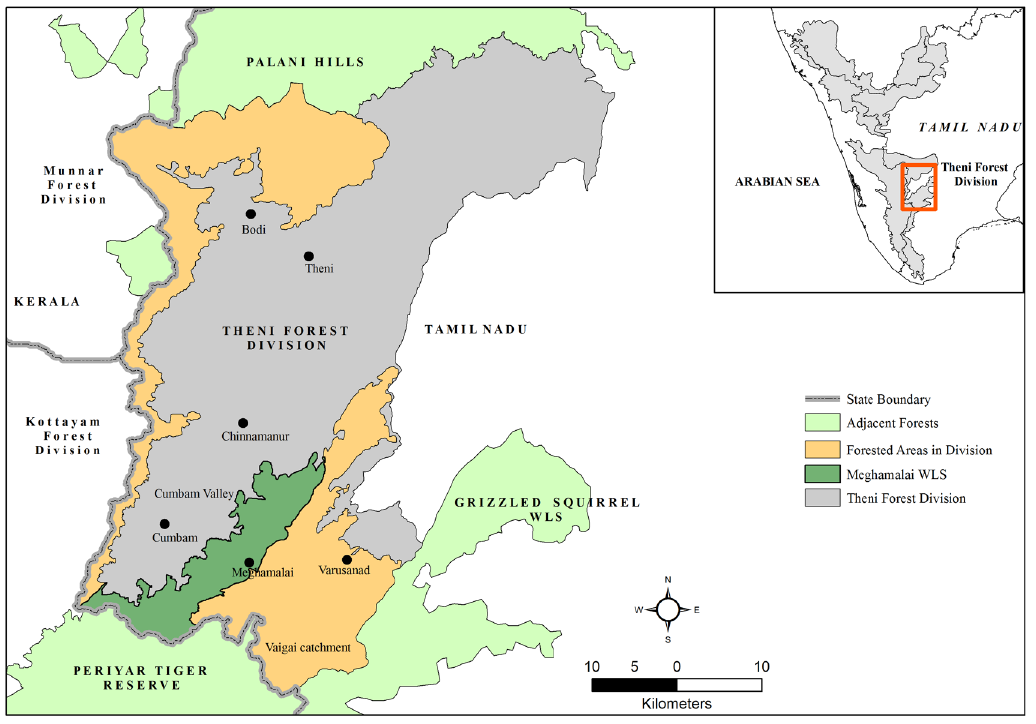
Figure 1. Location of Meghamalai and adjoining areas, Western